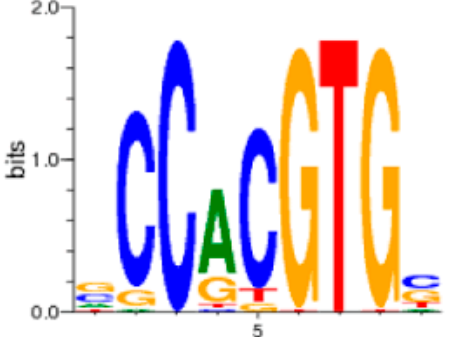
Figure 4. The consensus glucocorticoid response element (GRE) found in glucocorticoid-responsive genes [80]. Letter heights represent the percentage occurrence of the corresponding base at the given consensus sequence position.